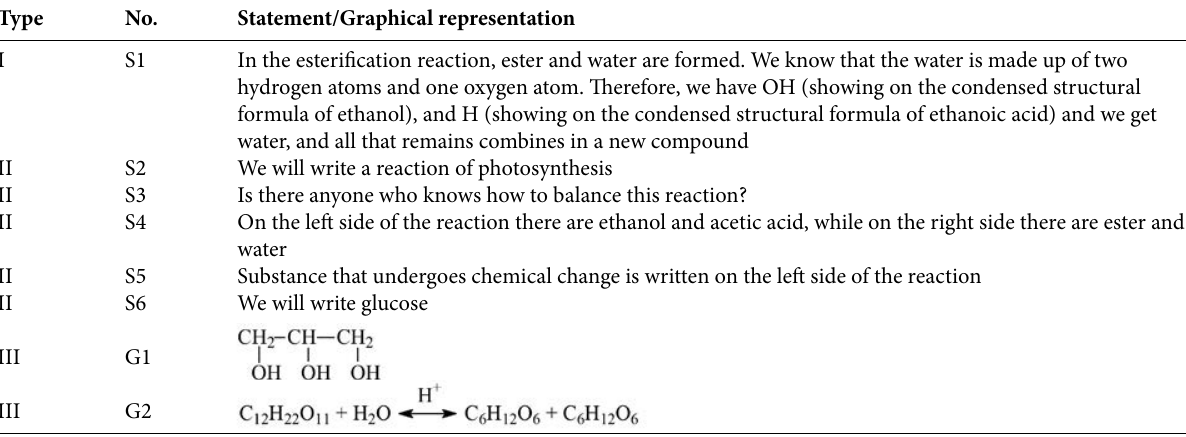
Table 3. List of Imprecise Statements in relation to Submicro-Symbolic Level